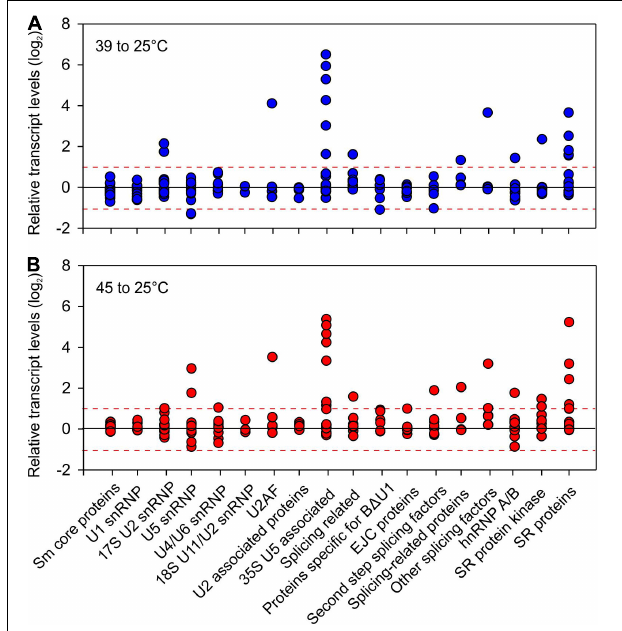
FIGURE 3 | Relative transcript levels of tomato orthologs of genes involved in pre-mRNA splicing. Tomato orthologous genes of splicing related proteins were obtained by ASRG database (Wang and Brendel, 2004) using InParanoid (Sonnhammer and Östlund, 2015; Simm et al., 2016). The transcript levels were obtained from Hu et al. (2020a) on seedlings from four cultivars exposed to (A) 39 ◦ C or (B) 45 ◦ C for 1 h and are presented as relative to 25 ◦ C